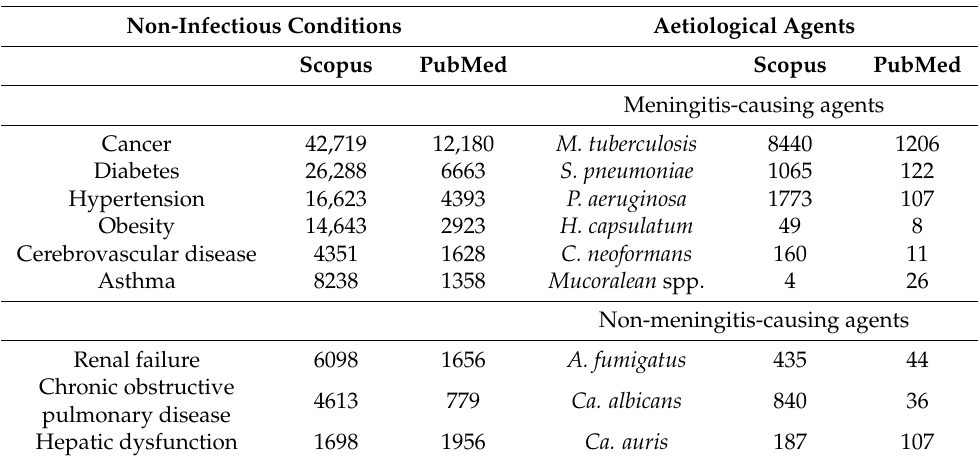
Table 1. The disproportionate reports concerning the co-occurrence of SARS-CoV-2 with non- infectious compared with infectious